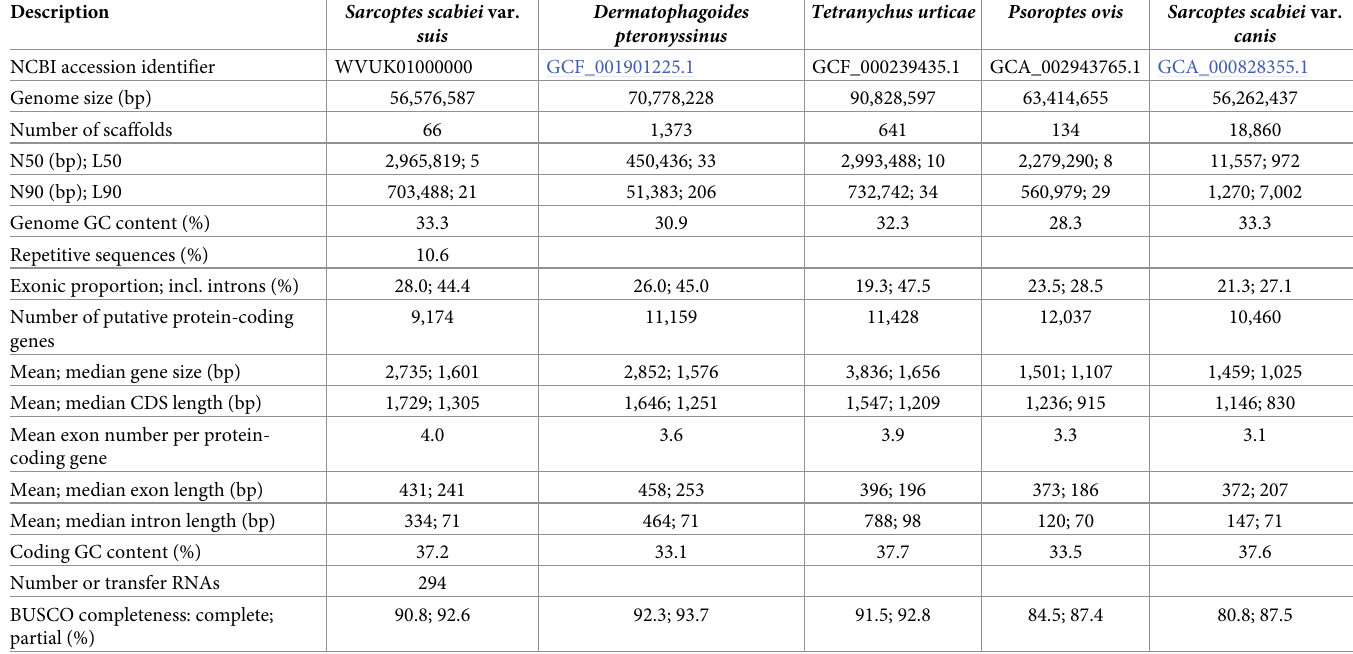
Table 1. Features of Sarcoptes scabiei draft